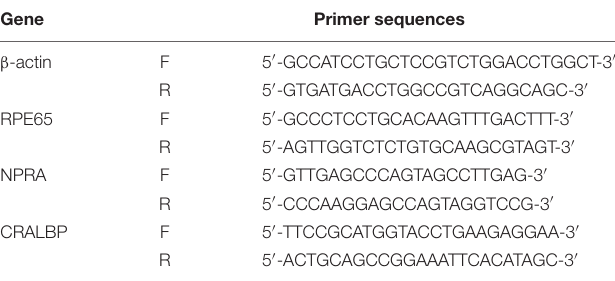
TABLE 1 | The primer for β -actin, RPE65, NPR-A, and CRALBP mRNA. Gene Primer sequences